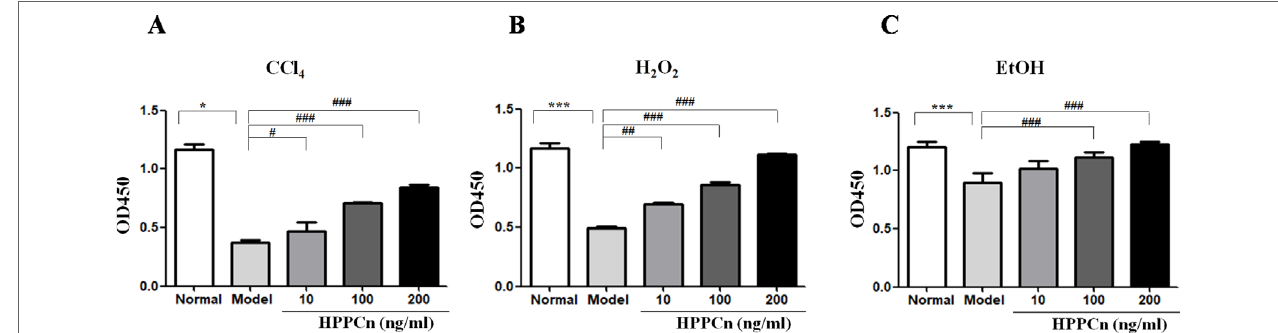
FIGURE 1 | rhHPPCn increased the survival of SMMC7721 cells injured by toxic substances. A CCK8 assay was used to evaluate the protective effect of rhHPPCn on SMMC7721 cells injured by different toxic chemicals. (A) Treated with different concentrations of rhHPPCn for 24 h after 10 mmol/L CCl 4 injury. (B) Treated with